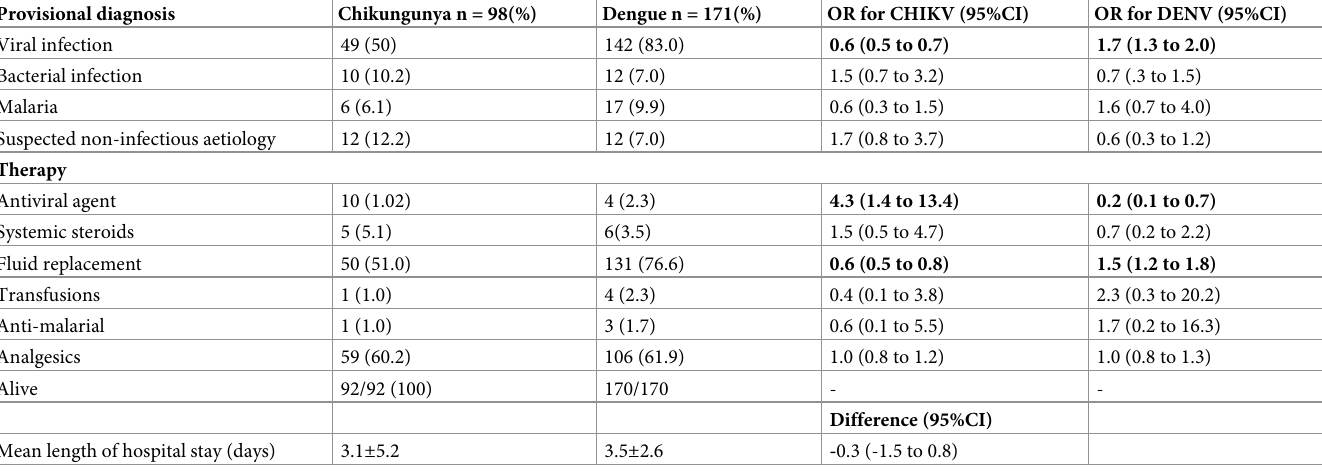
Table 3. Clinical diagnosis and management profile with outcomes of patients suffering from acute Chikungunya and Dengue enrolled from Sindh, Pakistan